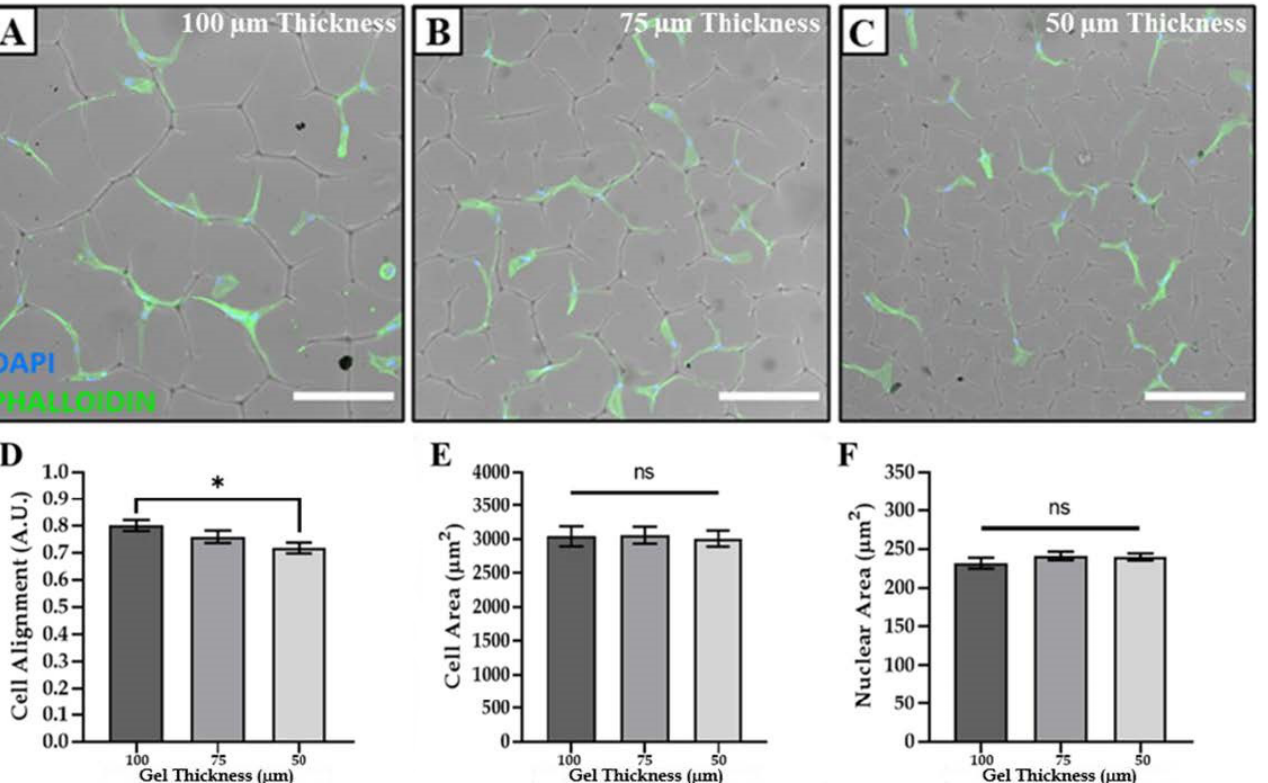
Figure 5. Cell alignment could be tailored by surface topography without affecting cell size. DAPI/phalloidin of MSCs seeded at 500 cells/cm 2 on AZO-PA hydrogels with ( A ) ~100, ( B ) ~75 and ( C ) ~50 µ m gel thickness (scale bar = 250 µ m) and the effect of topography type/periodicity distance on ( D ) cell alignment, ( E ) cell area and ( F ) nuclear area. * indicates p < 0.05; ns indicates no significant differences.